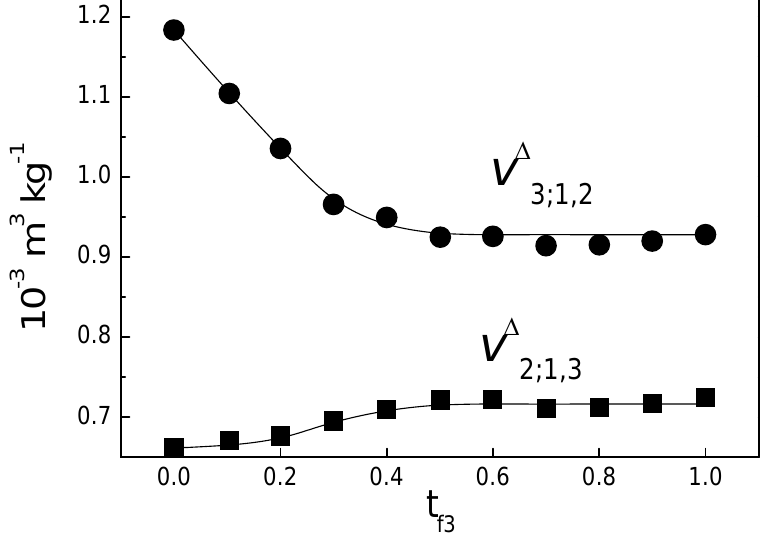
-TAB) , v Δ , as function t (data taken from ref. 10 f3 3;1,2